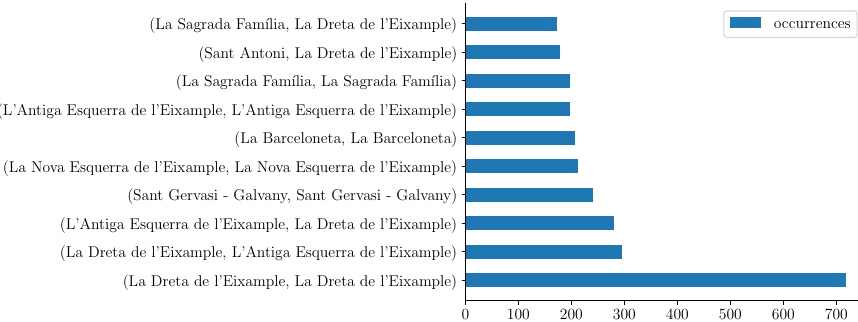
Figure 7. Ten most common combinations of starting/finishing neighborhoods for